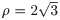
Impact of spatially correlated positional disorder in hexagonal RGC mosaics on iso-orientation domain layouts.
A Generation of spatially correlated disorder in hexagonal RGC mosaics (see text and Methods). White dots mark ON RGC cells, gray dots marks the perfectly hexagonal ON RGC lattice before distortion. Colors of the arrows and underlay indicate direction of RGC displacements (right colorbar). Magnitude of displacement is indicated by color saturation (bottom colorbar). Note that nearby RGCs move into similar directions and with similar magnitude. Scale bar indicates retinal distances, assuming ON/OFF lattice constant of 170μm. B Larger region of the mosaic shown in A (black square). Colors as in A. Contour lines mark lines of constant det(J(x)) (see text). Scale bar indicates retinal distances. C-E Unfiltered model domain layout (left), thresholded and smoothed layout (middle) its amplitude spectrum (right) for noise correlation length ξ = 5 and different noise amplitudes (η = 0.1 (C), η = 0.2 (D), η = 0.4 (E)). White squares in middle panels indicate wavelength of pattern as measured by wavelet analysis (see Methods). Scale bars indicate cortical distance with parameter choices as in Fig 2 and cortical magnification factor ≈ 1 (see [32]). F Marginal amplitude spectra of smoothed domain layouts for ξ = 5 and different disorder strengths. G Pinwheel density of model layouts as a function of disorder amplitude and correlation length. Red surface indicates experimentally determined value (ρ = 3.14), green surface indicates pinwheel density in the disorder-free case (ρ=23). Values for ρ ≥ 5 are drawn as a plane at ρ = 5. H As G, but pinwheels per square millimeter ρ^. Note that the absolute number of pinwheels is largely constant. All other model parameters as in Fig 2.